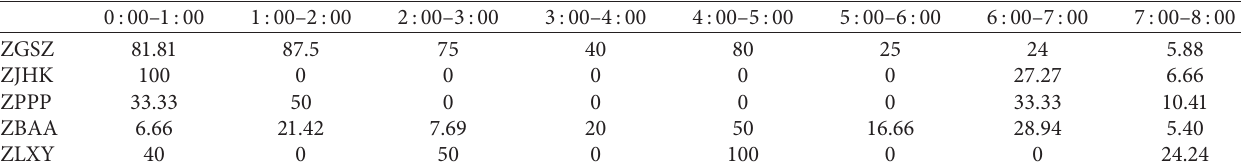
Table 4: Samples of airport normal release rate